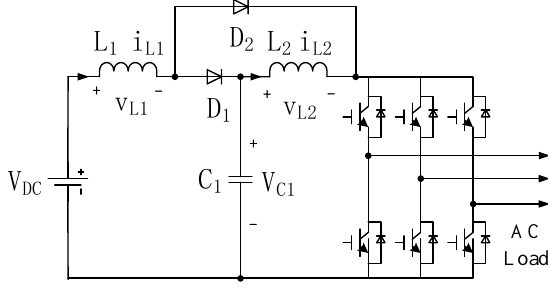
Figure 1. The topology of a half quasi-Z-source inverter.